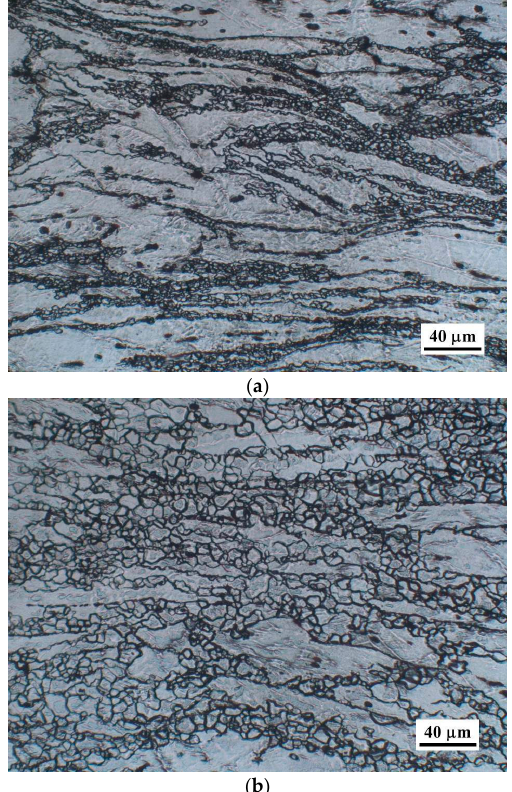
Figure 7. Microstructures of specimens deformed in ( a ) Domain 1 (300 ◦ C/0.001 s − 1 ), and ( b ) Domain 2 (380 ◦ C/0.01 s − 1 ). The compression axis is